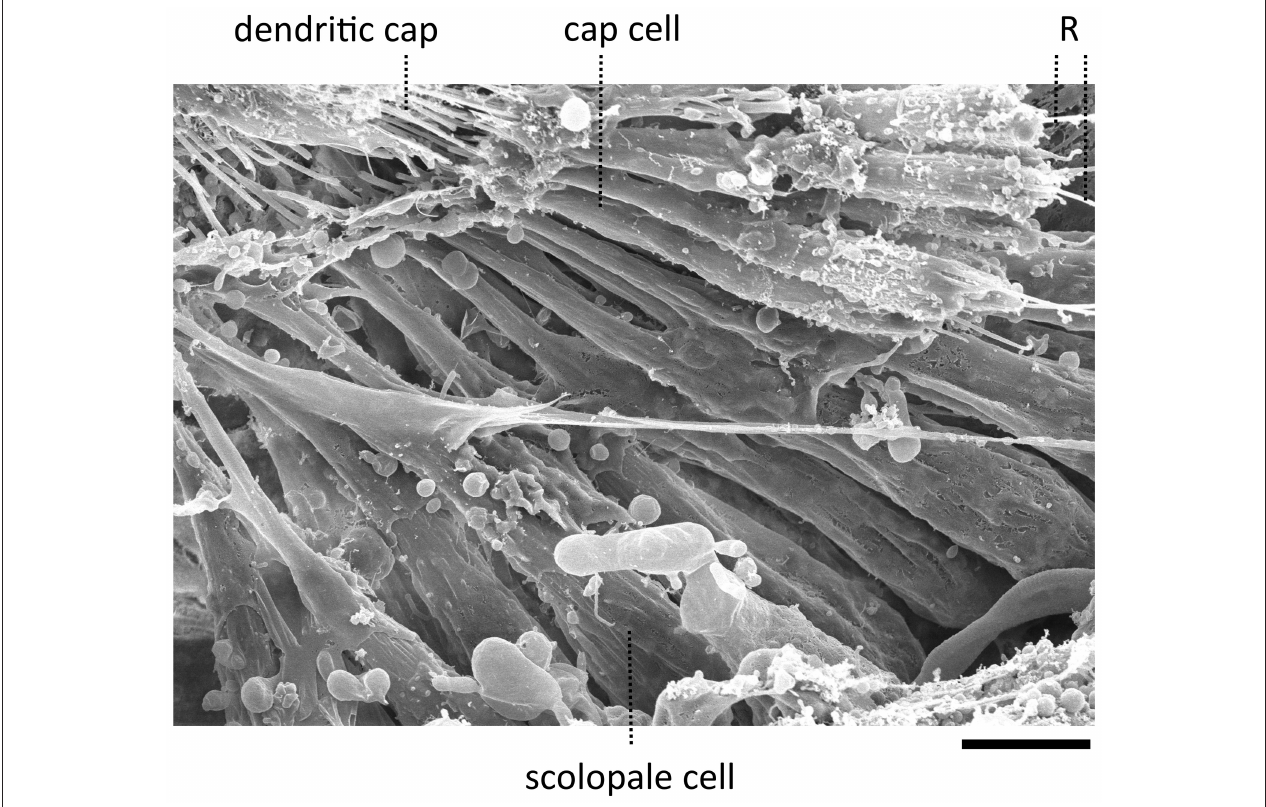
FIGURE 3 | Scanning electron micrograph of a JO within a goggatomized A2. R—putative scolopale rods protruding from broken scolopidia. Scale bar 5um.